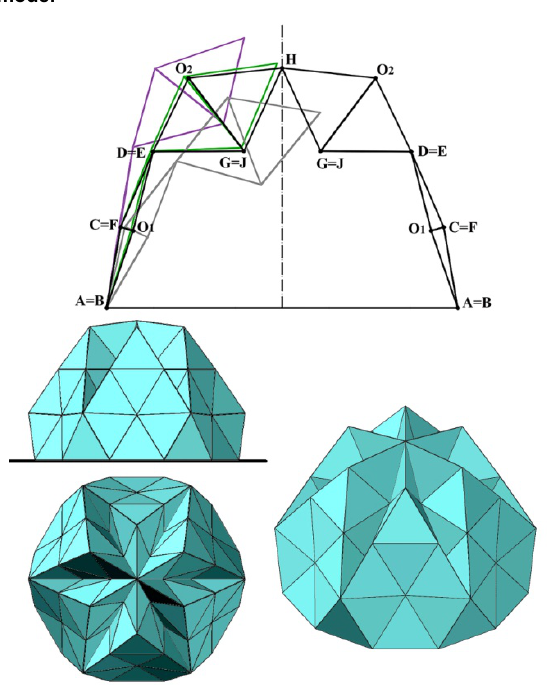
Figure 7. The CP IV-12B(C * QO 2* ) - vertical section of three positions of a unit cell, orthogonal projections and spatial